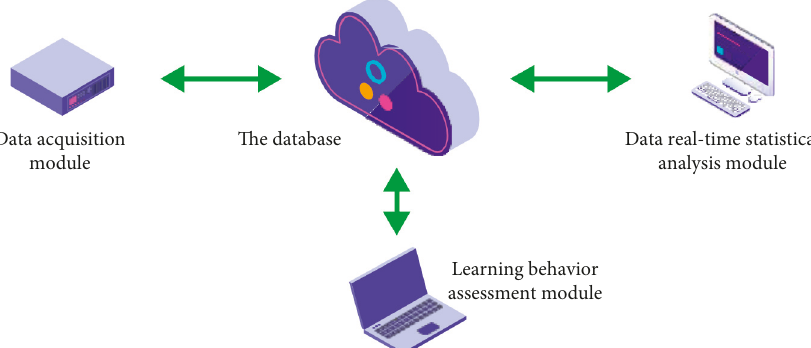
Figure 7: Overall system structure drawing.